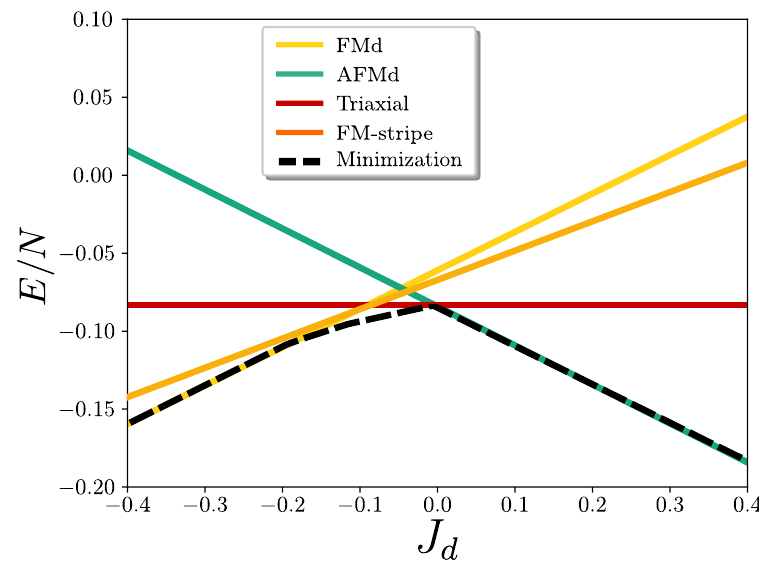
Figure 11: Ground state energy per site for the classically ordered phases: FMd, ≈ − 0.02 and J = 1. The energy of the triaxial state AFMd and FM-stripe for J χ 1 corresponds to minimizing the chiral term. The energy coming from the gradient descent (GD) minimization, Sec. 3, is also shown for comparison. Same color code as in Fig.